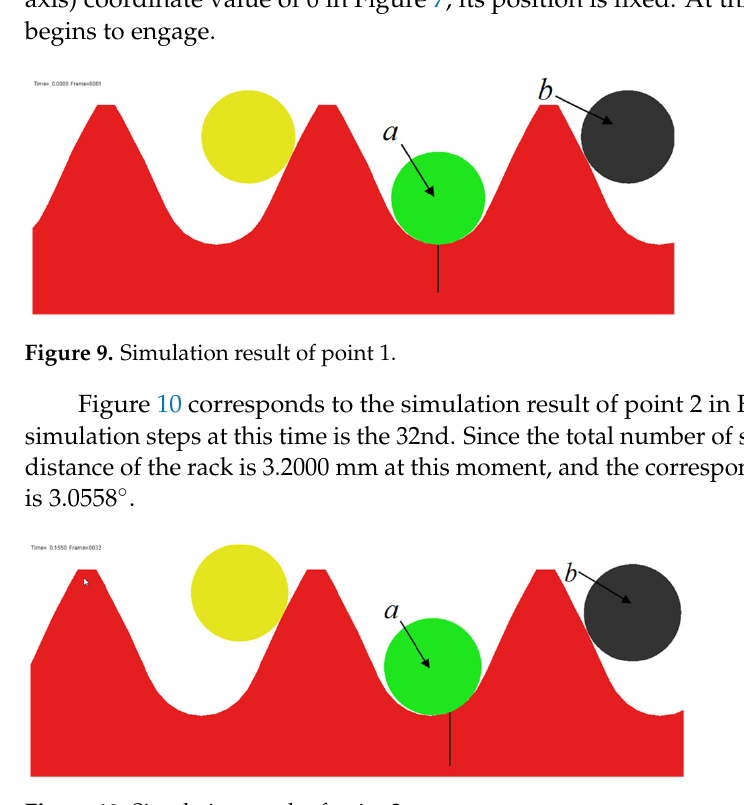
Figure 10. Simulation result of point 2. Figure 11 corresponds to the simulation result of point 3 in Figure 8. The number of this moment, and the corresponding roller pinion angle is 6.2070°.